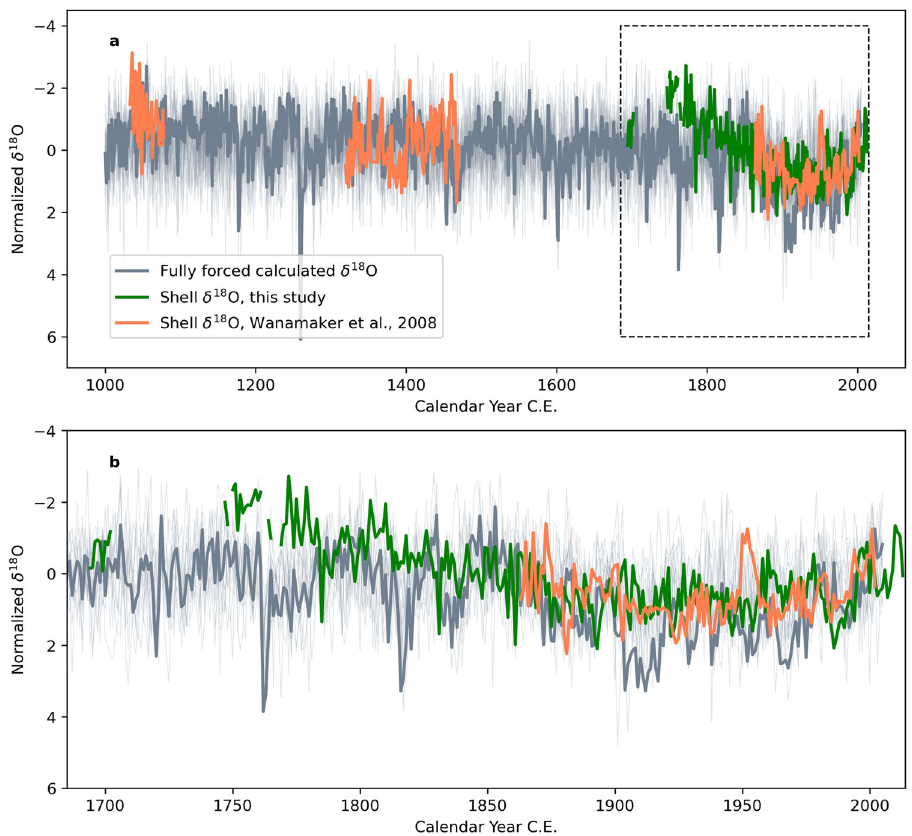
Fig. 5 Oxygen isotope records in the Gulf of Maine over the last 1000 years. a Time series of oxygen isotopes measurements from this study and Wanamaker, et al. 15 compared to those calculated from temperature and salinity output from the fully forced CESM-LME simulations, averaged over the Gulf of Maine region at 35 m depth (see the Methods section in the main text for details). The dashed rectangle represents the time period of the graph shown in ( b ) for ease of comparison. Note both y axes are inverted. b As in ( a ) but for the shorter period of 1685 – 2013. The legend shown in ( a ) applies to both ( a ) and ( b ). All oxygen data are normalized (z-scores) so that they can be plotted on the same scale.